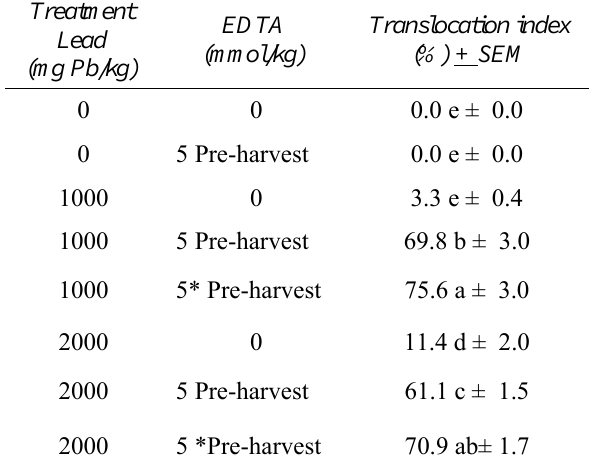
Table 2: Effects of various concentrations of Pb and chelates on per cent translocation indices of tall fescue. Means with a similar letter do not differ significantly using Fisher’s Protected LSD test ( p ≤